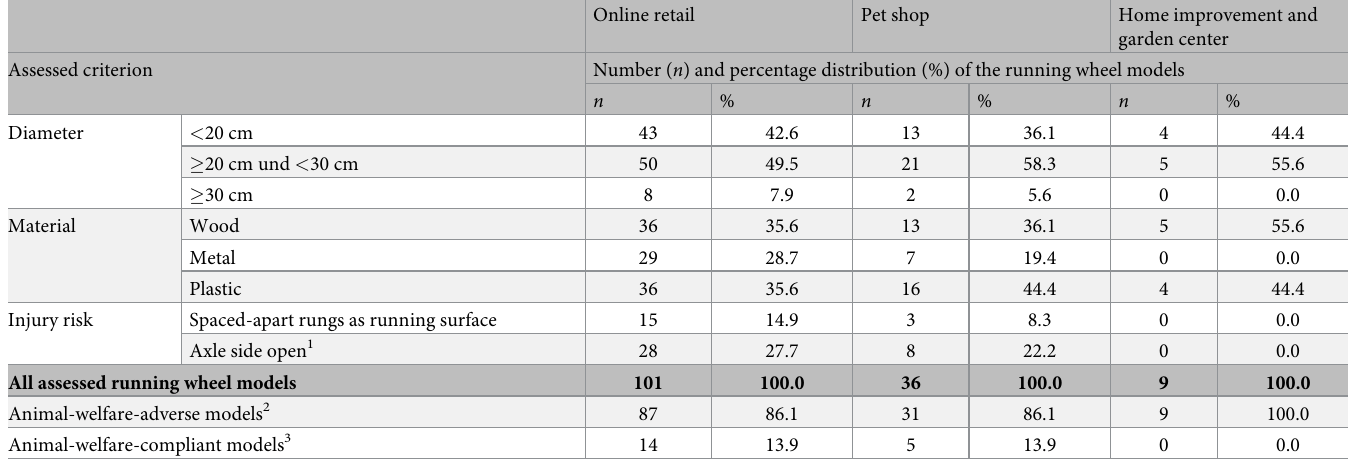
Table 6. Design features of running wheel models purchasable from German pet supply retailers (online via internet shops, on site in pet shops or home improve- ment and garden centers). Online retail Pet shop Home improvement and garden